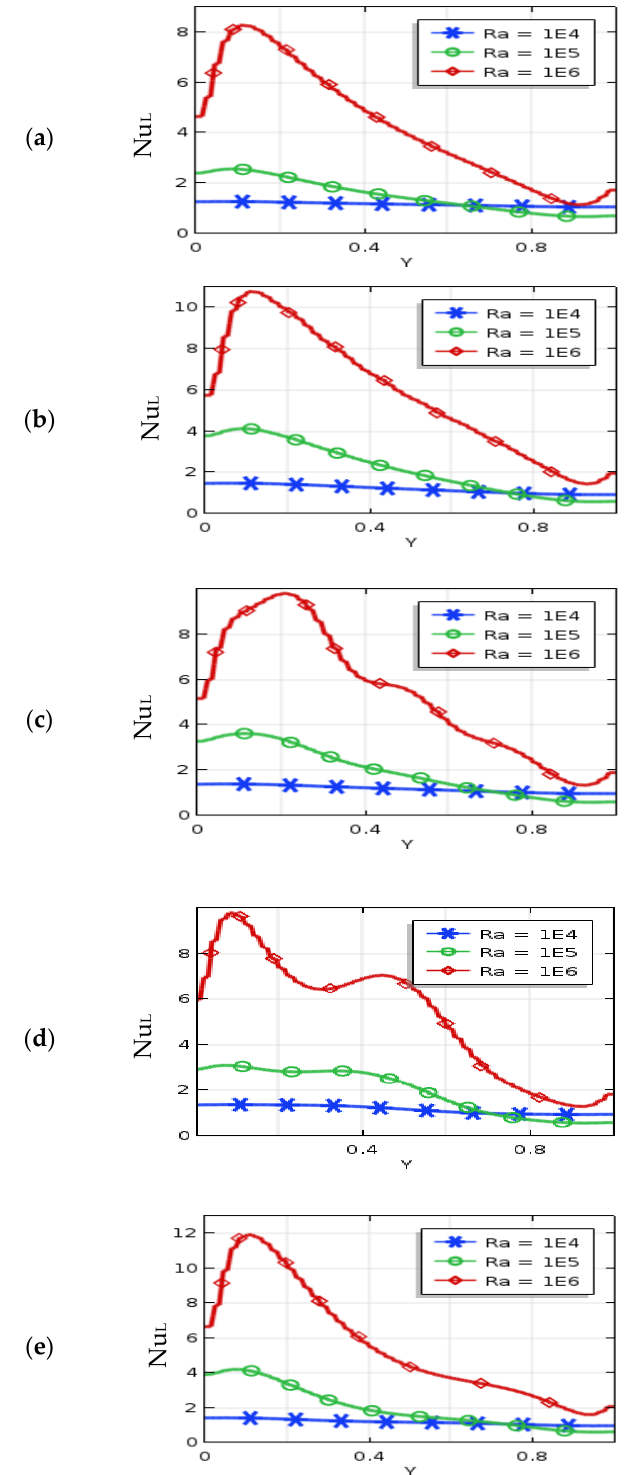
Figure 8. Local Nusselt number for Rayleigh number ( Ra ) and ( a ) umf, ( b ) λ = 0.1, ( c ) λ = 0.25, ( d ) λ = 0.5, and ( e ) λ = 1 when Ha = 30, d = 10 nm, ϕ = 0.04, n = 3, and τ = 1.